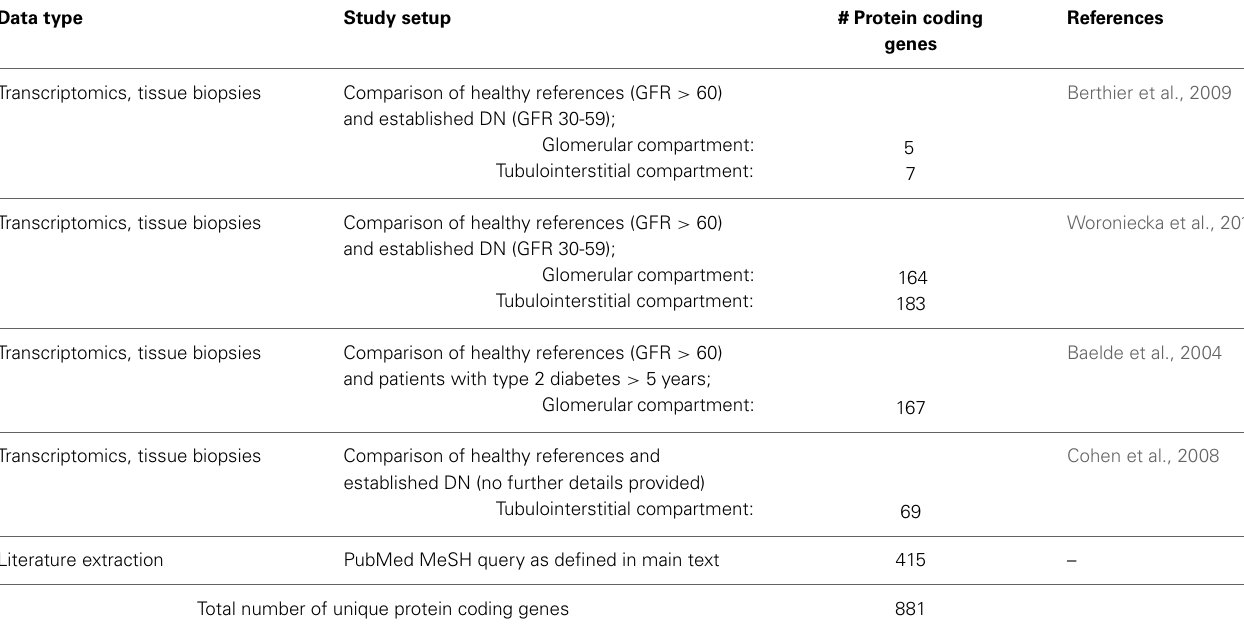
Table 1 | Diabetic nephropathy molecular data